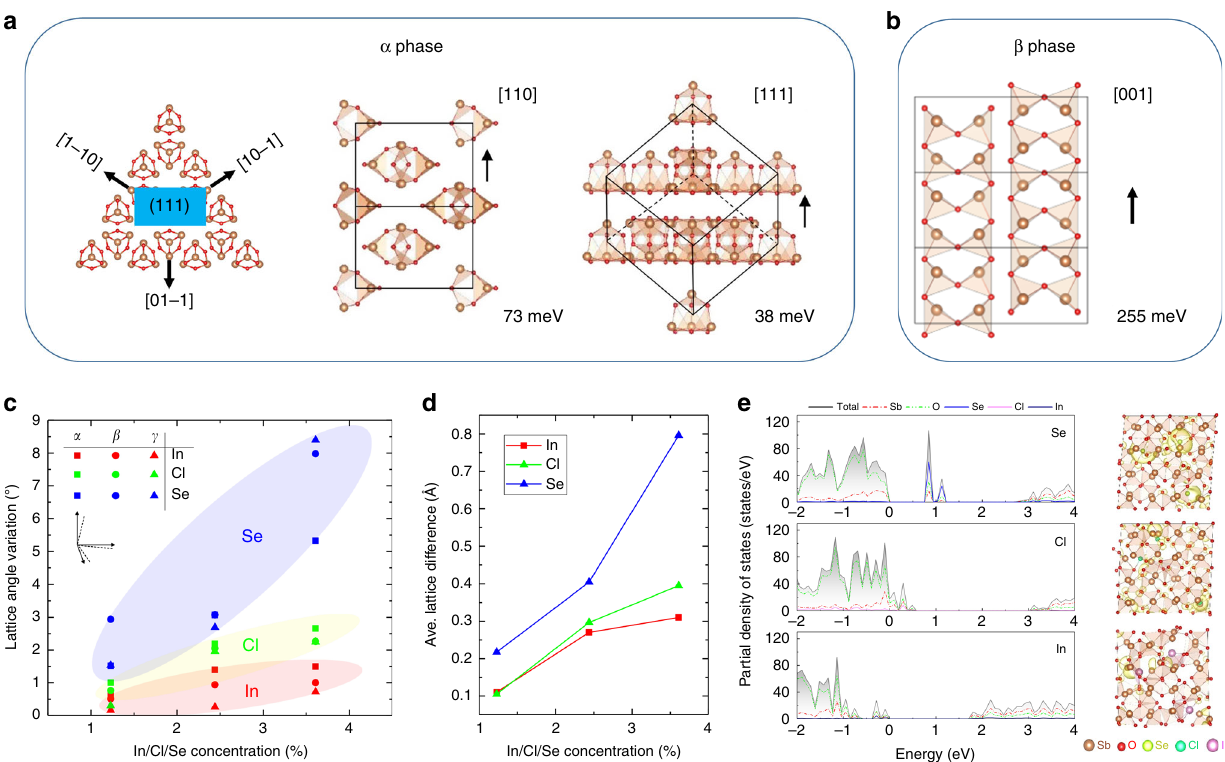
Fig. 4 DFT-calculation of the effect of passivators. a Crystallographic preferential growth orientations and surface energy comparison for speci fi c Sb 2 O 3 crystal direction (110) and (111) in α phase, and b (001) in β phase. Brown balls, Sb atoms. Red balls, O atoms . c , d Structural distortions referenced to the pristine Sb 2 O 3 , which is described by the variations of crystal angle ( α , β , γ ) and average lattice differences ( Δ X , X = Se, Cl and In). e Partial density of states for Sb 2 O 3 with Se, Cl and In absorption on (111) surface and the local charge densities ( ρ = 0.005 eÅ − 3 ). The shaded areas in ( e ) are total